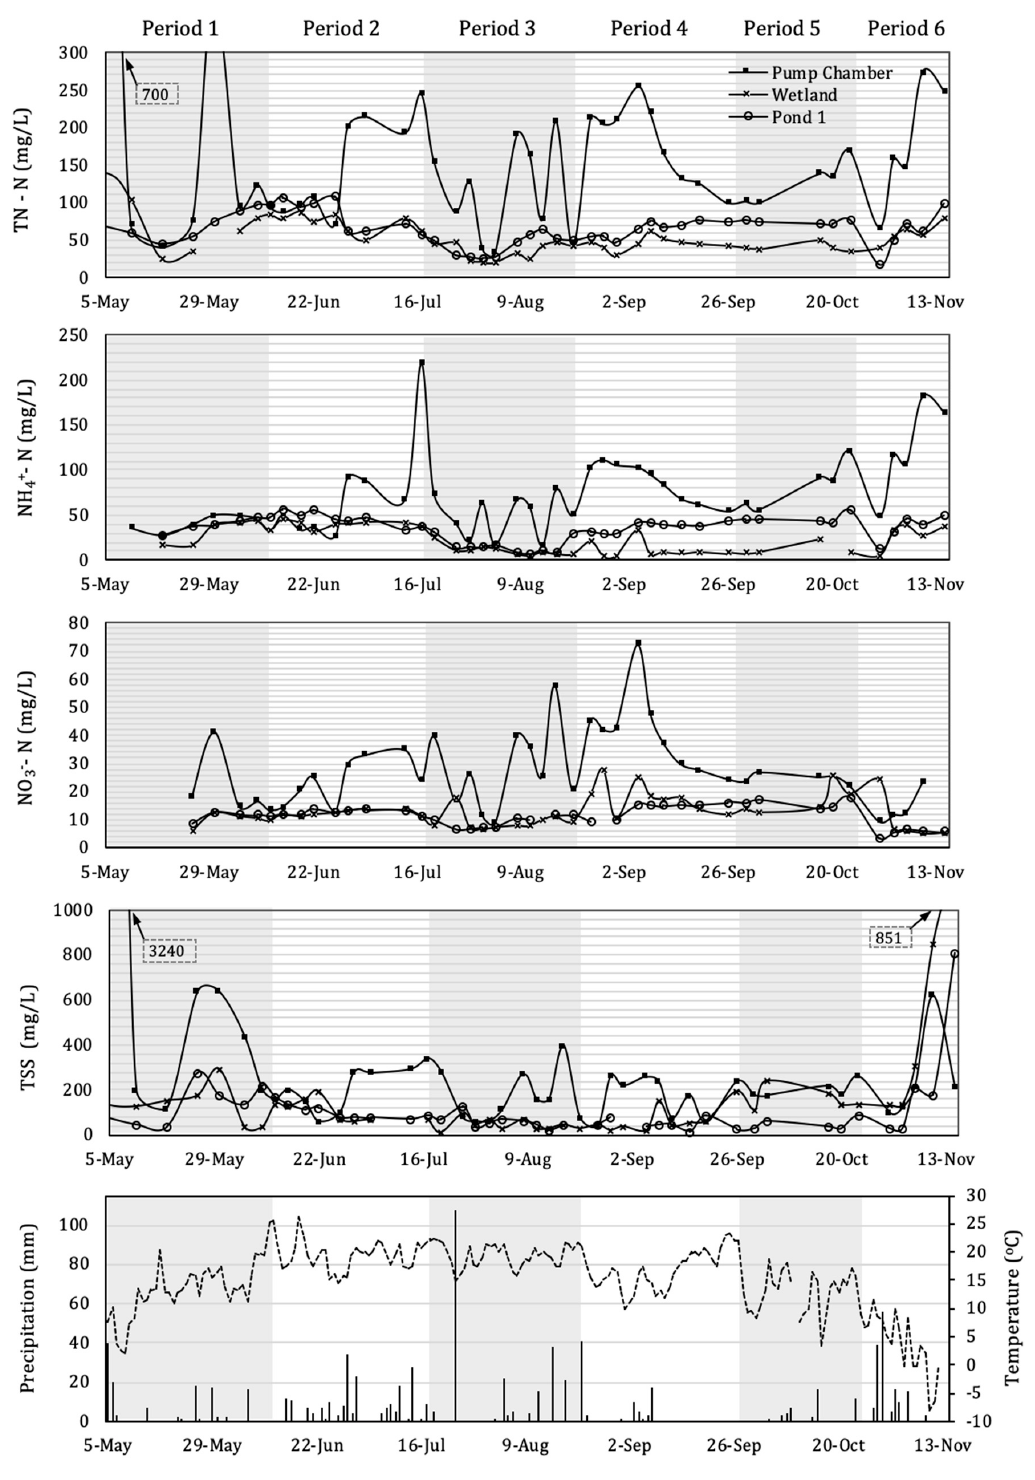
Figure 2. Daily precipitation, average daily temperature, and wetland inflow (P1) and outflow (W) concentrations along the six selected periods (shaded bands) during the 2017 operating season of the following constituents: ( a ) total phosphorus (TP), orthophosphate (PO 4 − 3 ), chemical oxygen demand (COD), biological oxygen demand (BOD 5 ) and ( b ) total nitrogen (TN), ammonia (NH 4 + ), nitrate (NO 3 − ), total suspended solids